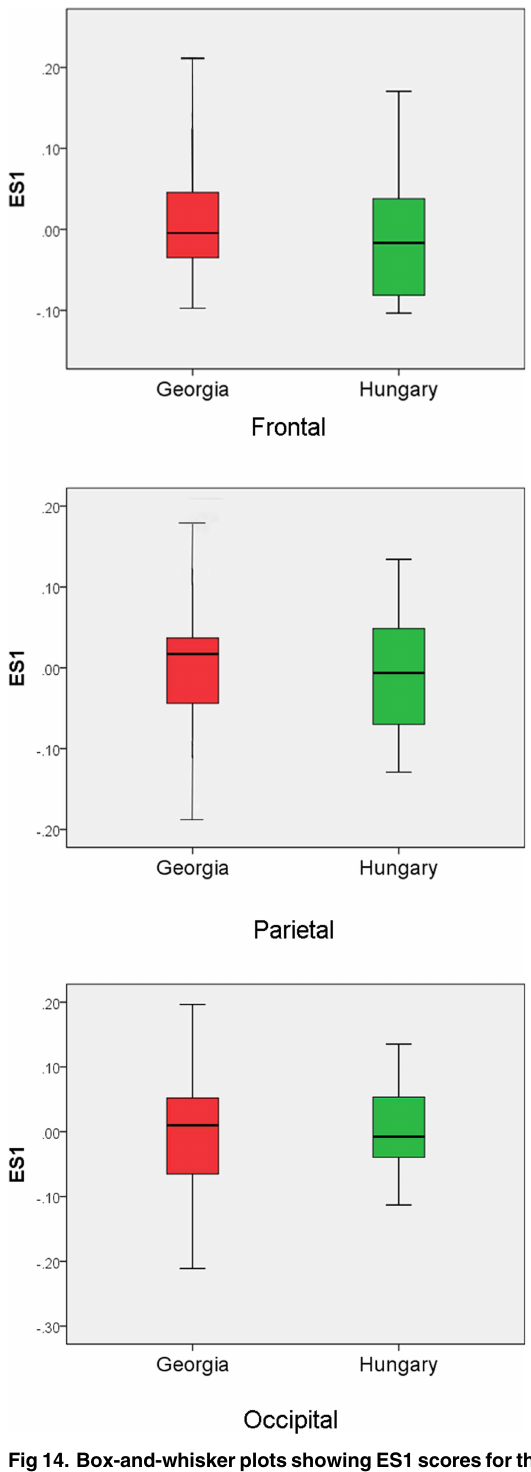
Fig 14. Box-and-whisker plots showing ES1 scores for the Georgian and Hungarian crania in frontal, parietal and occipital